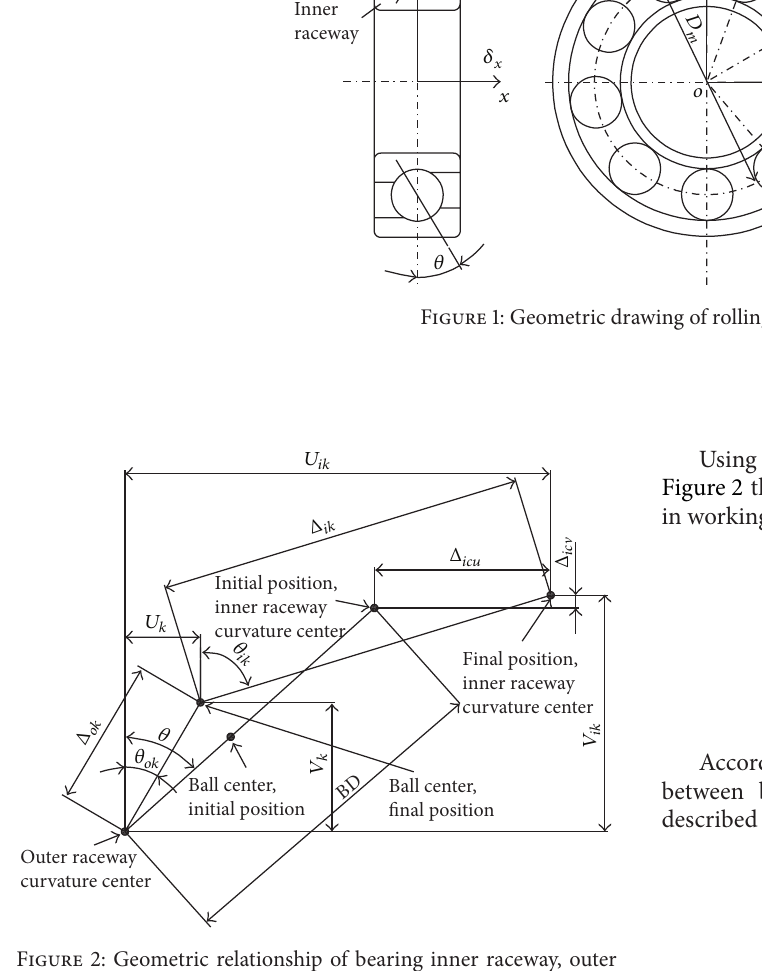
Figure 2: Geometric relationship of bearing inner raceway, outer raceway, and rolling